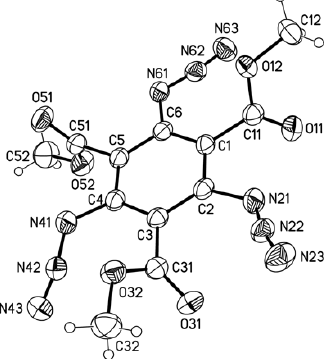
Figure 3. Molecular structure of 3a, displacement parameters are drawn at 30% probability level (for details, see supporting information and cif-file).